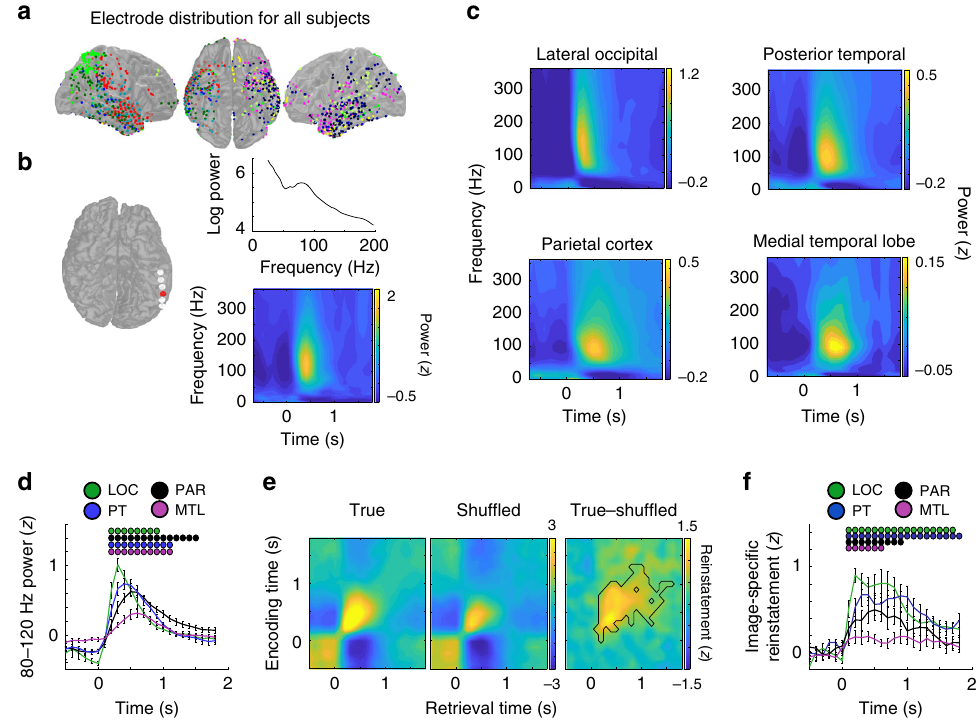
Fig. 2 Feedforward transmission of 80 – 120 Hz power between cortex and medial temporal lobe re fl ect speci fi c visual experiences. a Intracranial electrode locations for all 14 participants. Each color corresponds to an individual participant. b In a representative electrode in the posterior temporal lobe (red), a single trial exhibits an increase in power in the 80 – 120 Hz band during recognition testing (top). Across all trials in this electrode, images during the recognition period elicited increases in 80 – 120 Hz power. c Across participants, image presentation during the recognition period evoked increases in 80 – 120 Hz power in the lateral occipital cortex (LOC), posterior temporal lobe (PT), parietal cortex (PAR), and medial temporal lobe (MTL). d Average time course of 80 – 120 Hz power during the recognition period in each brain region across participants (200 ms sliding windows, 50% overlap; image appears at t = 0). Dots indicate signi fi cant increases in 80 – 120 Hz power compared to baseline, corrected for multiple comparisons across 6 LOC, 8 PAR, 10 PTL, and 10 MTL participants ( p < 0.05, permutation procedure). e Reinstatement of 80 – 120 Hz power distributed across all electrodes, averaged across all participants. The difference in average reinstatement between the true and shuf fl ed distributions re fl ects image-speci fi c reinstatement across all participants (black outline, p < 0.05, permutation procedure). f Time series of average image-speci fi c reinstatement across 6 LOC, 8 PAR, 8 PT, and 10 MTL participants during the recognition period. Dots indicate signi fi cant increases in image-speci fi c reinstatement corrected for multiple comparisons ( p < 0.05, permutation procedure; image appears at t = 0). All error bars indicate standard error of